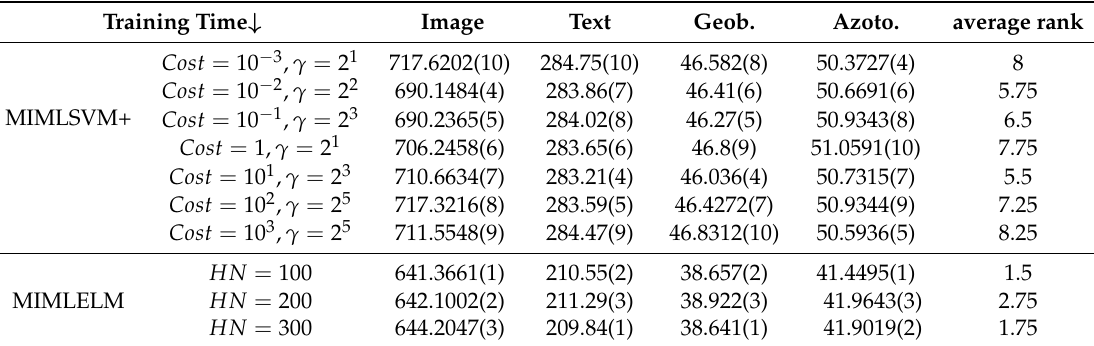
Table 13. Friedman test of the training time.